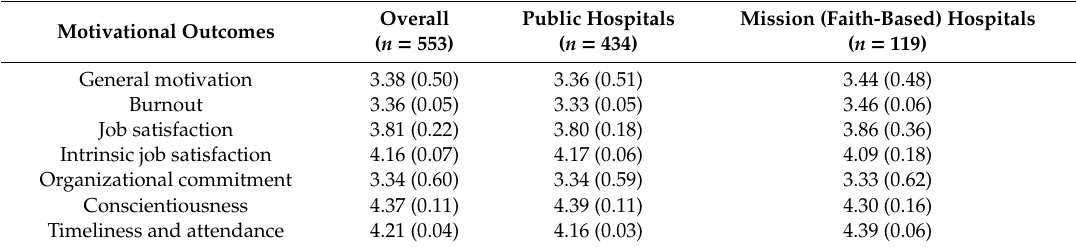
Table 2. Mean scores * (SD; 1–5 Likert scale) of motivating outcomes for the sample of healthcare professionals by hospital ownership ( n =